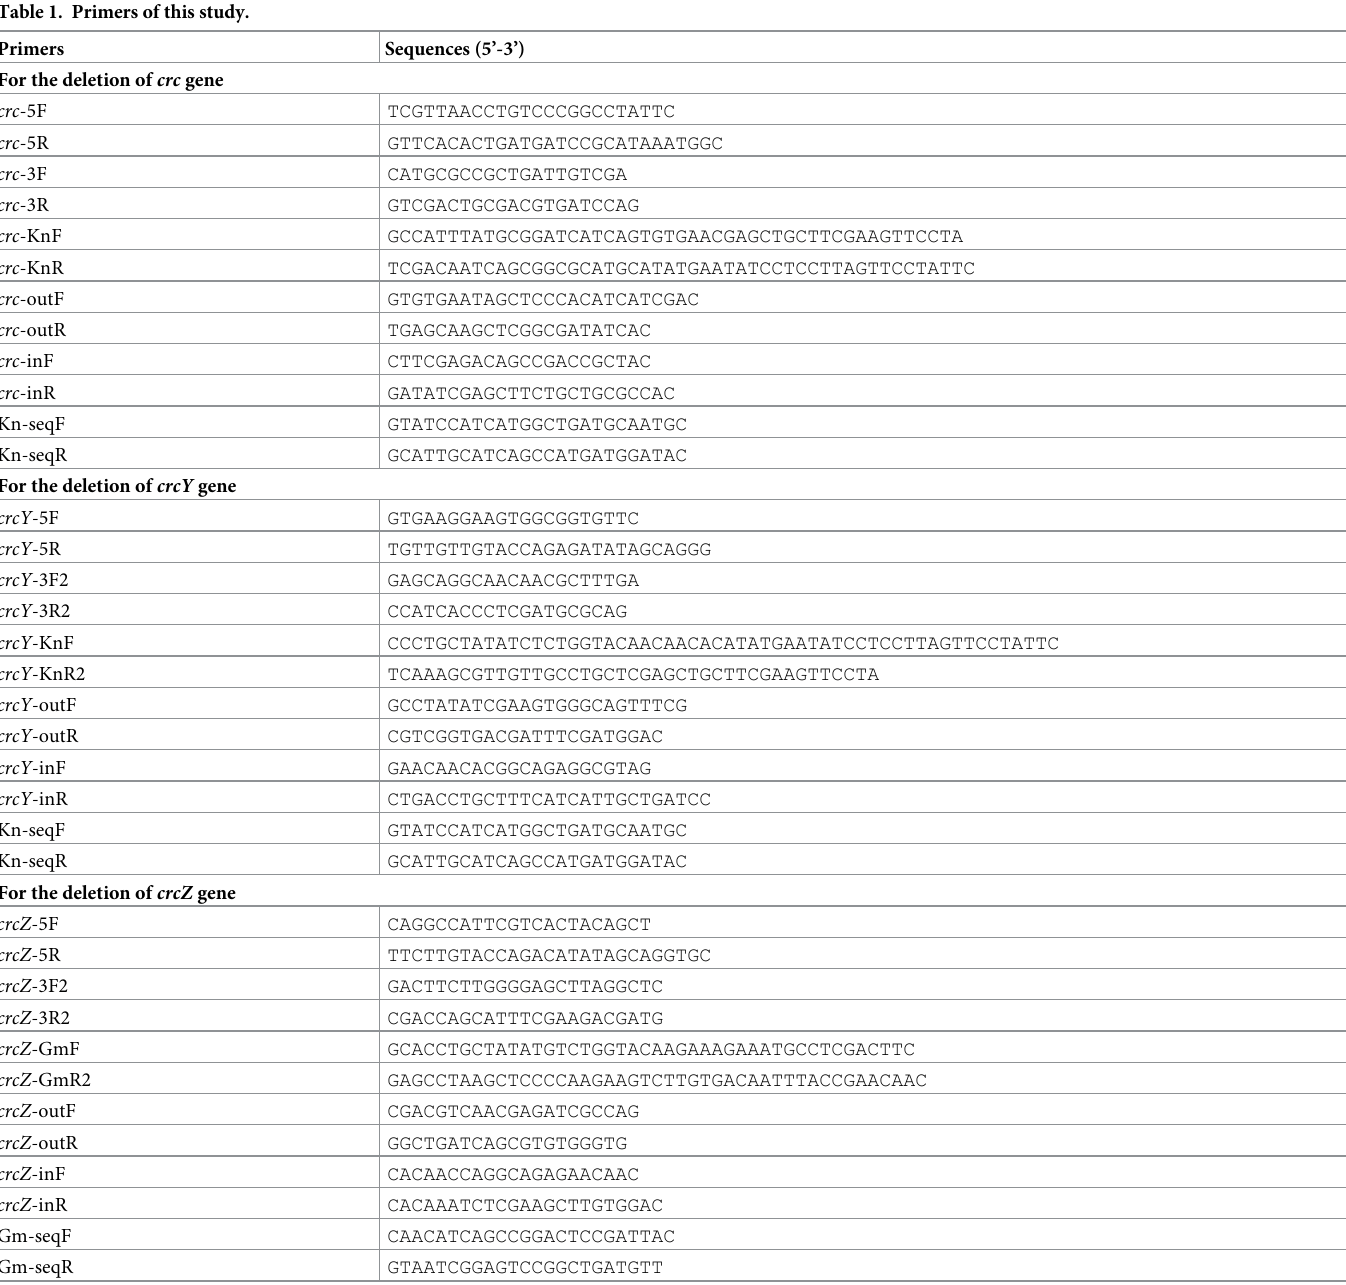
Table 1. Primers of this